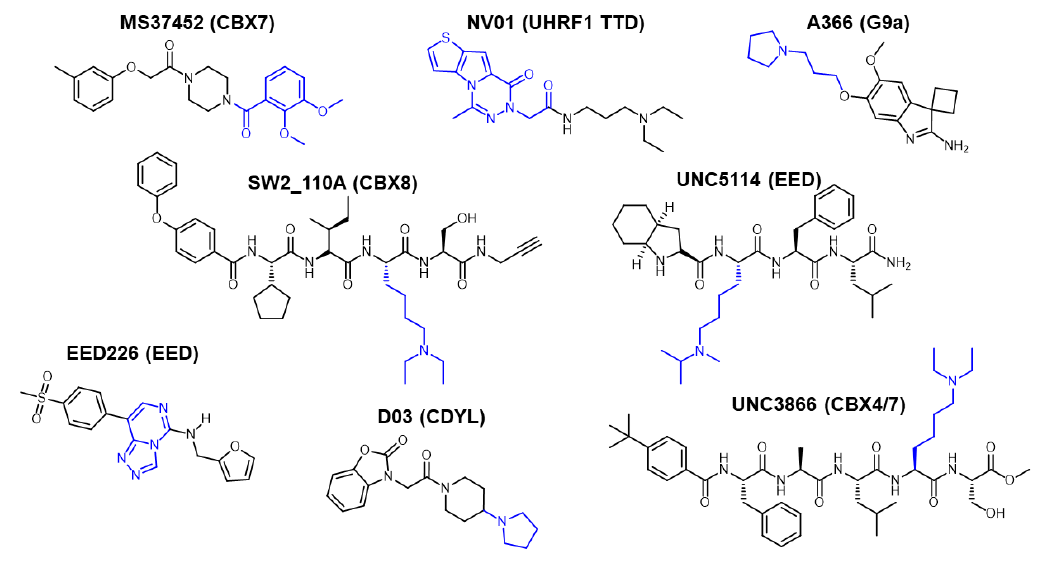
Figure 1. Examples of methyl-lysine domain inhibitors with the functionality that interacts with the methyl-lysine pocket highlighted in blue. Protein targets are included in